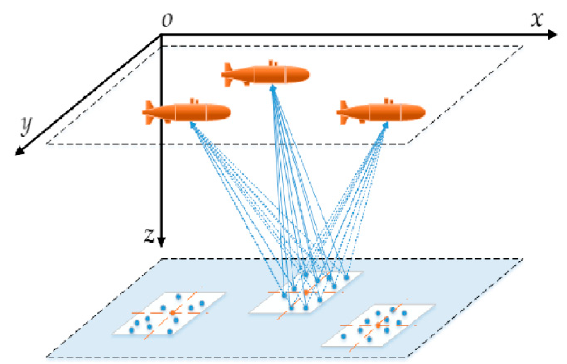
Figure 3. Description of the targets with uncertainty in position.